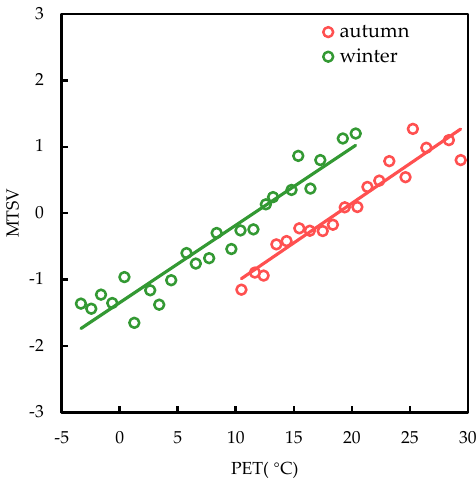
Figure 2. Correlation between MTSV and PET in autumn and winter.